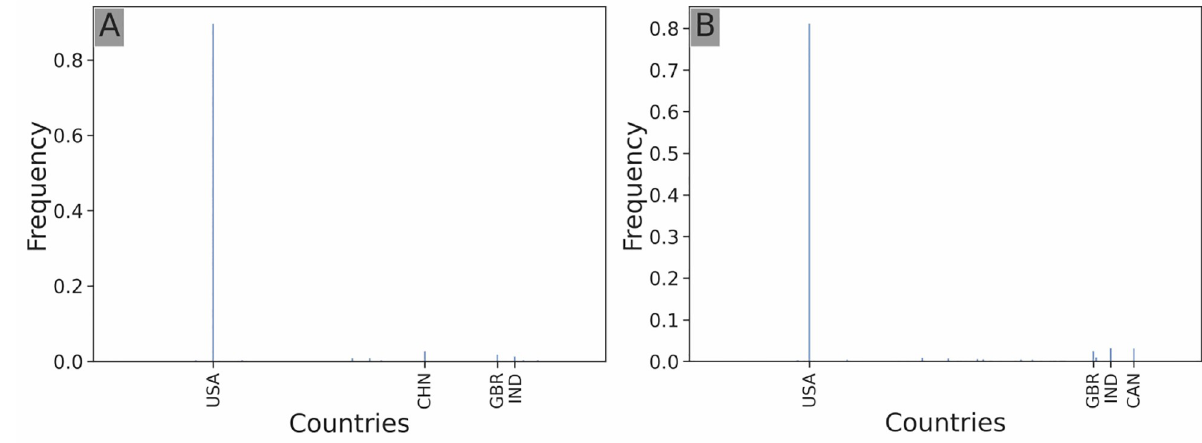
Fig 3. Geographical investment distribution. Geographical investment distribution of Softbank Capital ( A ), and Y Combinator ( B ). Only the top 4 target countries in terms of frequency of investment are labeled. Both structures heavily target US-based ventures.